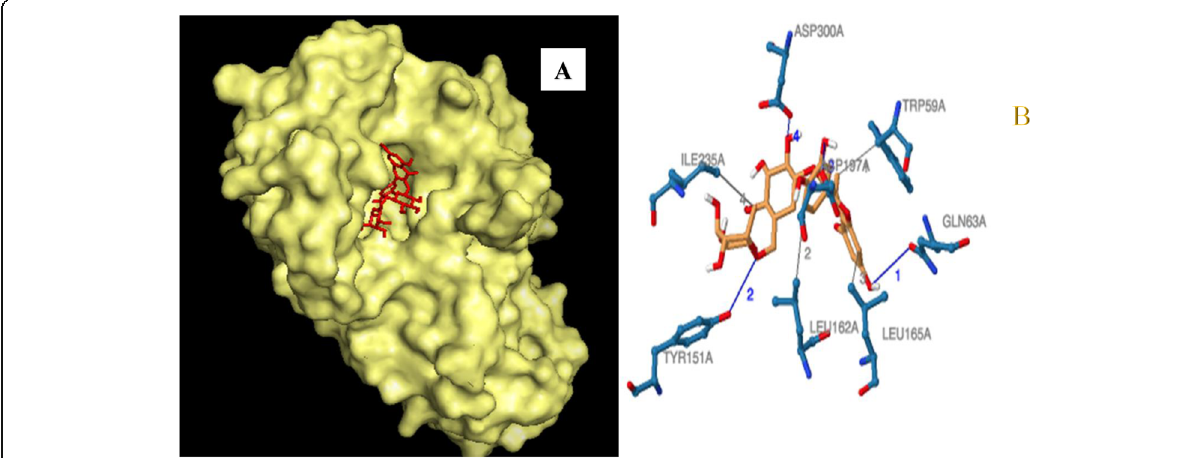
Fig. 13 Binding pose and binding site of rutin with α -amylase (panel A), molecular interaction of rutin with amino acid residues within the binding pocket of the protein structure (panel B)